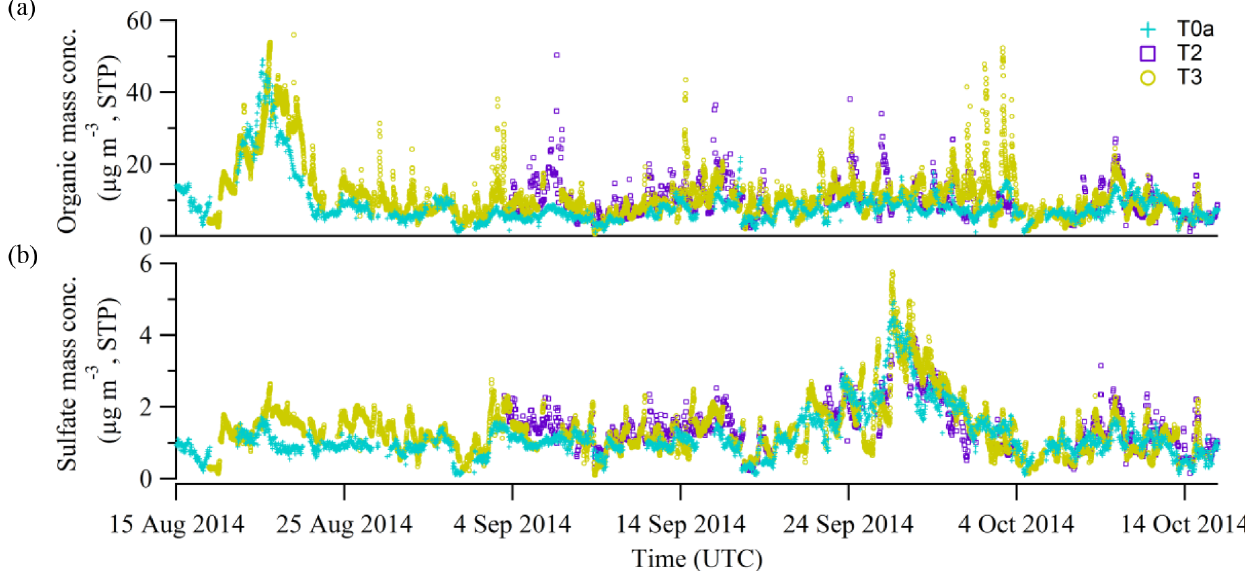
Figure 2. Time series of (a) organic and (b) sulfate mass concentrations at the T0a, T2, and T3 sites. Concentrations were adjusted to standard temperature (273.15K) and pressure (10 5